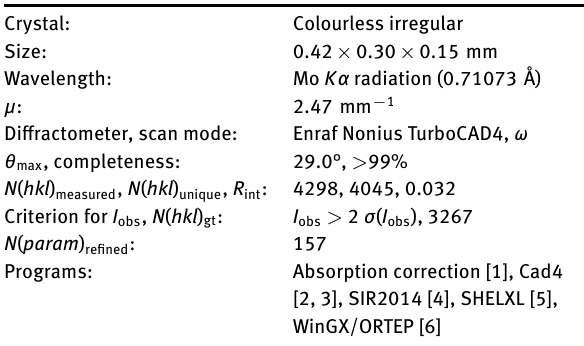
Table 1 contains crystallographic data and Table 2 contains the list of the atoms including atomic coordinates and dis- placement parameters. Table 1: Data collection and